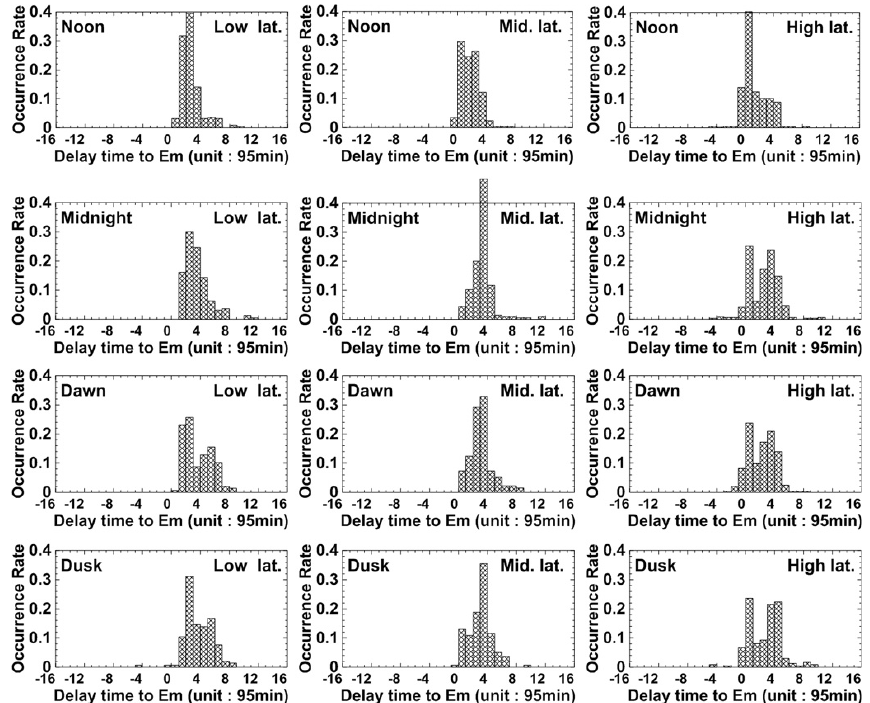
Fig. 10. Distribution of delay times of the storm-time density changes with E m at different latitudes in different LT sectors for the 35 storms studied.